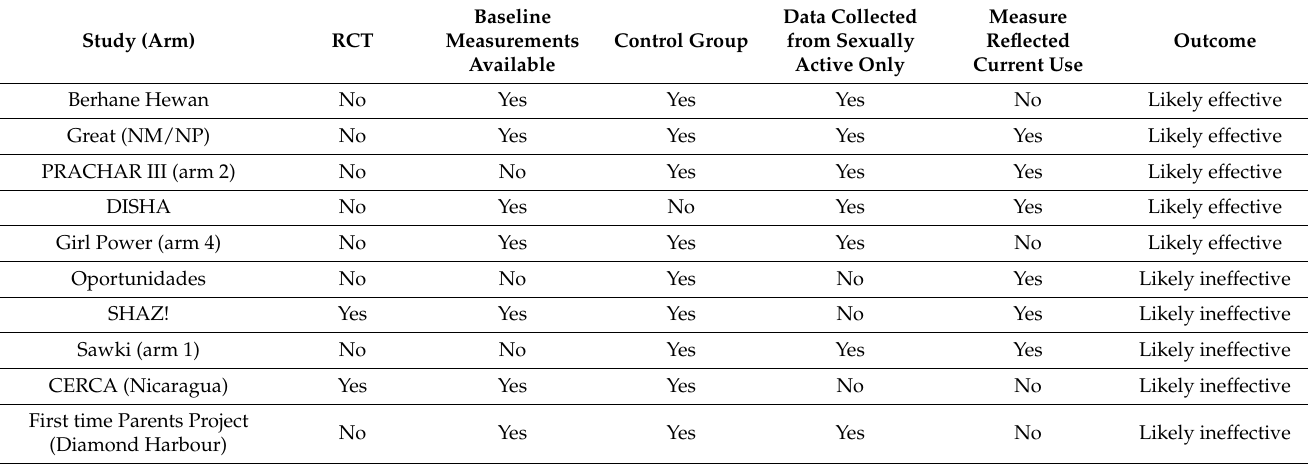
Table 2. Data table of least/most effective study arms and their methodological characteristics.